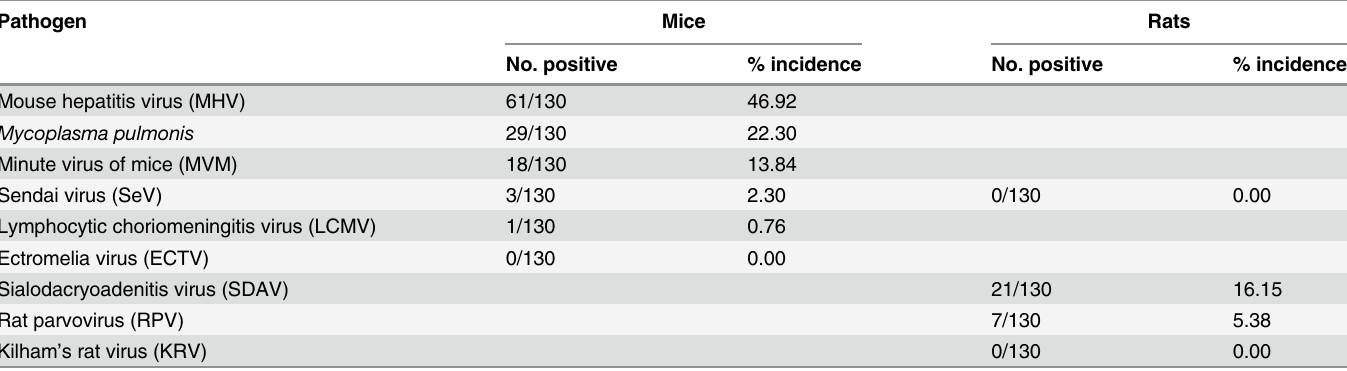
Table 1. Incidence of various pathogens in mice and